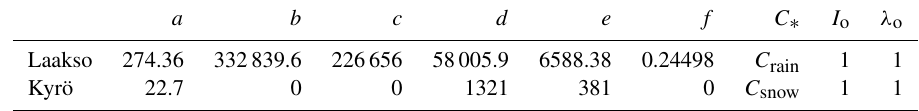
Table 1. Parameters used in Eq. (4) for below cloud scavenging from Laakso et al. (2003) and Kyrö et al. (2009). a b c d e f C ∗ I o λ o Laakso 274.36 332839.6 226656 58005.9 6588.38 0.24498 C rain 1 1 Kyrö 22.7 0 0 1321 381 0 C snow 1